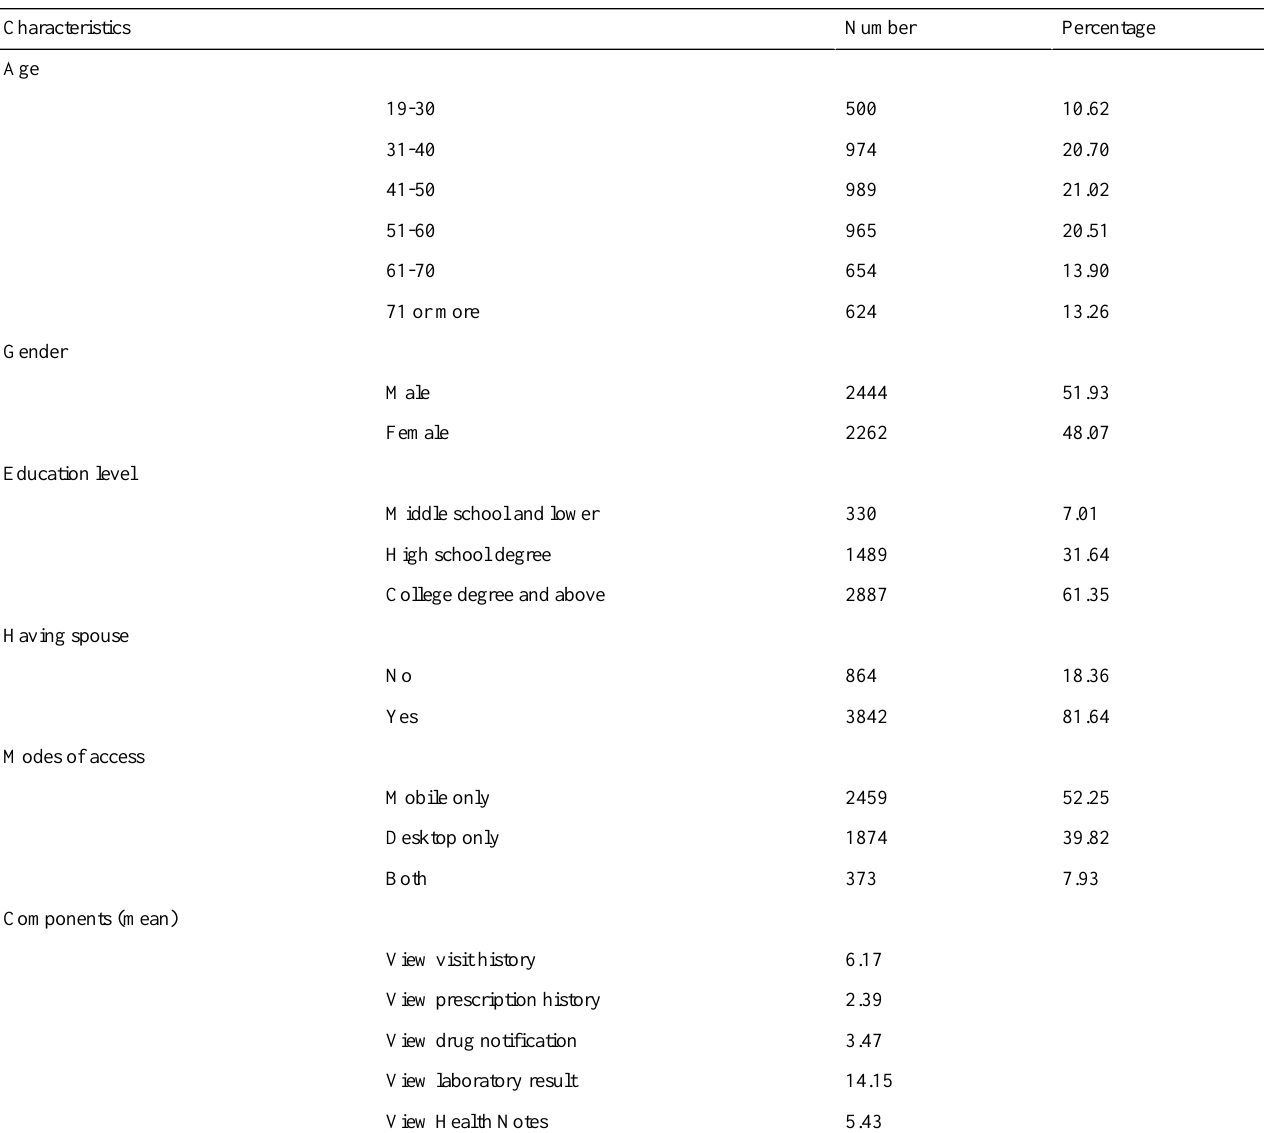
Table 1. Baseline characteristics.